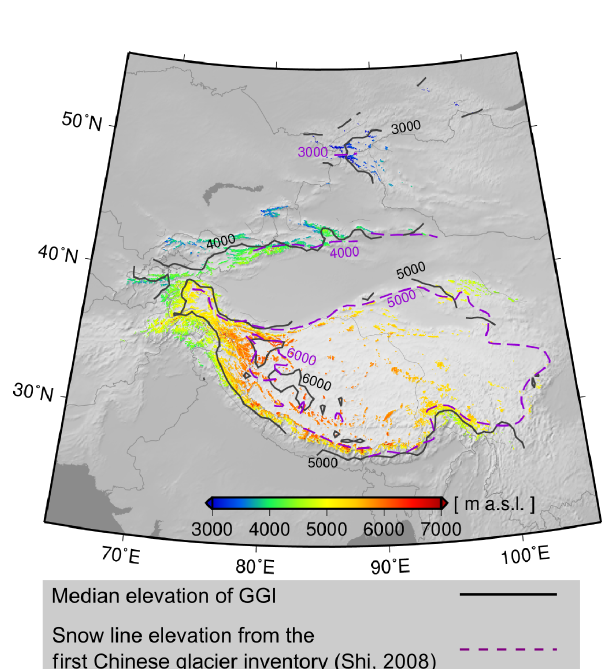
Figure 13. Distribution of glaciers in the GGI coloured by me- dian elevation. Purple dashed contours indicate snow-line elevations used in the Chinese glacier inventory (Shi,